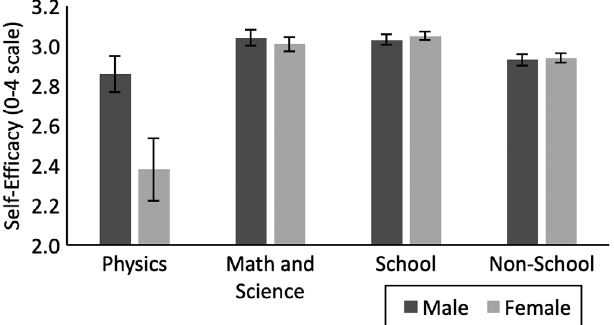
FIG. 1. Male and female students ’ predicted self-efficacy states. Error bars represent one standard error.